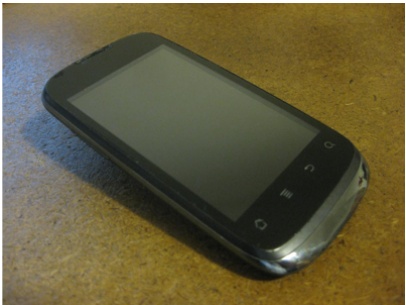
Figure 1: Smartphone used to test the reconstruction system: Huawei U8650 Sonic.